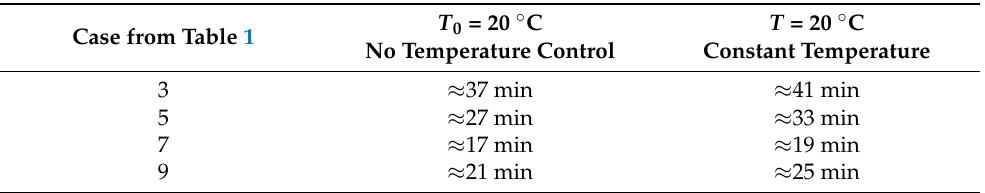
Table 3. Time for the polymerizing mixture to reach a viscosity value of 1000 mPa · s during a rheological test at a constant shear rate 1